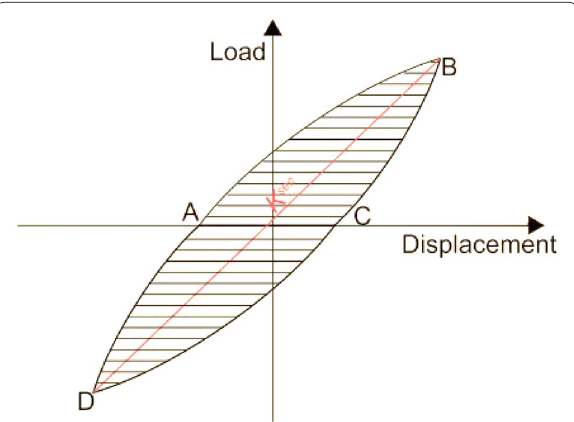
Fig. 14 Peak to peak secant stiffness calculation (Xue and Yang